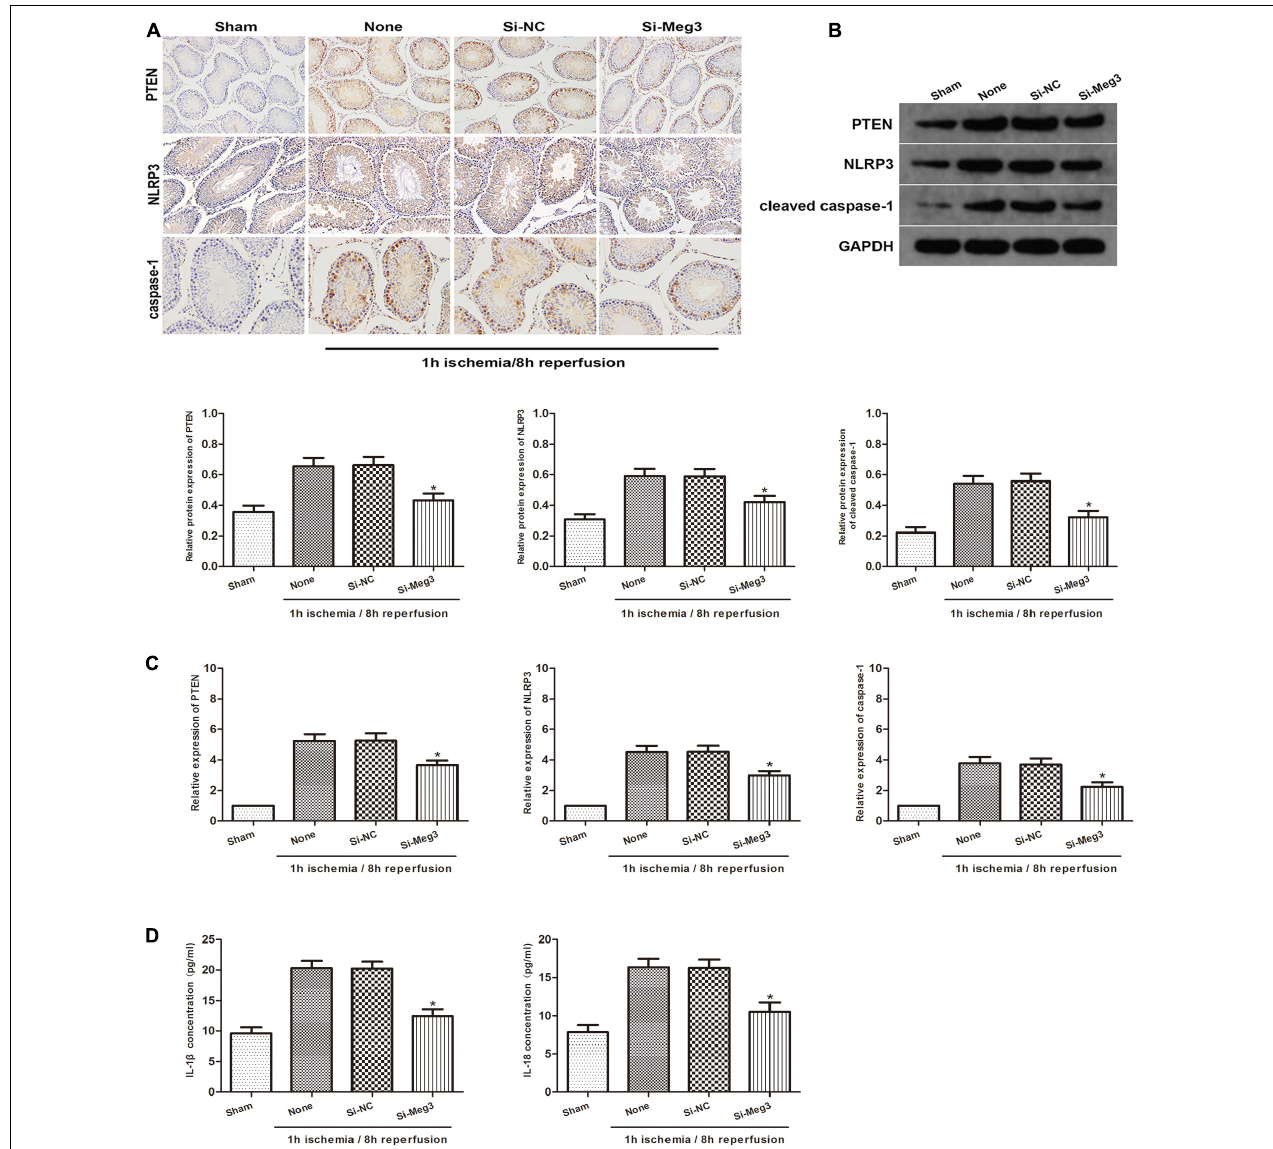
FIGURE 6 | lncRNA MEG3 promotes spermatogenic cell pyroptosis caused by testicular I/R in vivo . (A) Immunohistochemical staining of PTEN, NLRP3 and caspase-1 in testicular specimen transfected with si-NC or si-MEG3 at 8 h reperfusion after 1 h of ischemia. (B) PTEN, NLRP3, and caspase-1 expression in testicular specimen transfected with si-NC or si-MEG3 were detected by western blot at 8 h reperfusion after 1 h of ischemia. (C) qRT-PCR was executed to analyze the relative expression of PTEN, NLRP3 and caspase-1 in testicular specimen transfected with si-NC or si-MEG3 at 8 h reperfusion after 1 h of ischemia. (D) ELISA analysis was executed to measure IL-1 β and IL-18 expression in testicular specimen transfected with si-NC or si-MEG3 at 8 h reperfusion after 1 h of ischemia. The data are presented as the mean ± S.E.M. n = 6. * p < 0.05 vs.